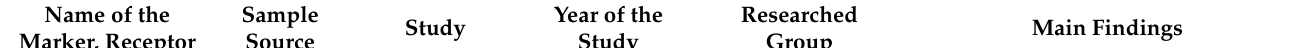
Table 6. The utility of telomerase activity, Ki-67, CD34, GDF15, miRNA in ULMS and ULM